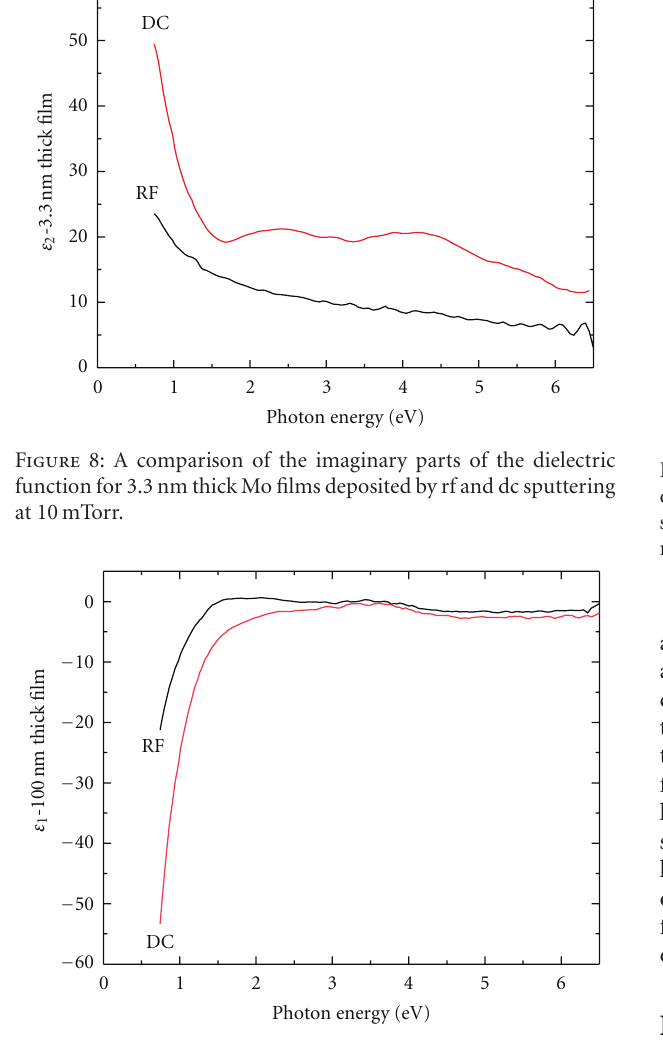
Figure 9: A comparison of the real parts of the dielectric function for 100 nm thick Mo films deposited by rf and dc sputtering at 10mTorr.